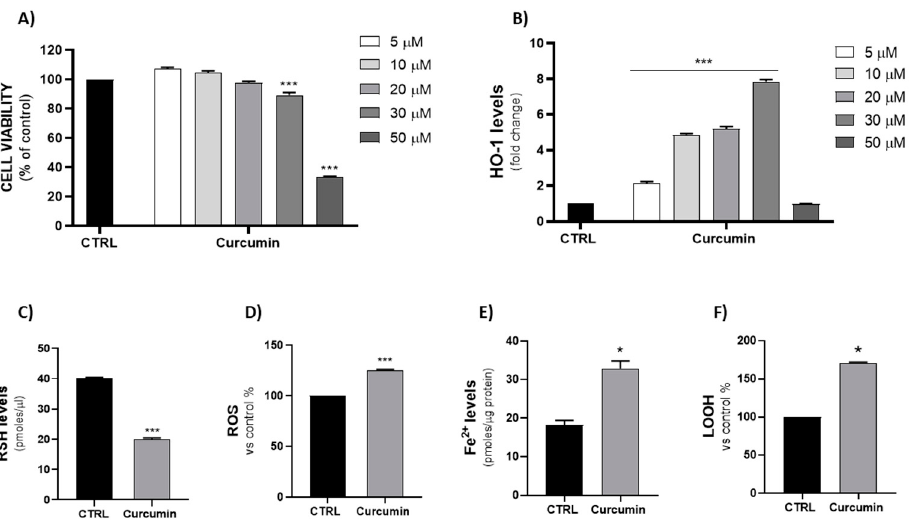
Figure 3. ( A , B ) Evaluation of curcumin (5, 10, 20, 30, 50 µM) treatment on MDA-MB 231 cells’ viability and HO-1 expression levels (*** p < 0.0005 vs. CTRL). ( C – F ) Effect of curcumin (30 µM) on RSH, ROS, Fe 2+ and LOOH levels (* p < 0.05, *** p < 0.0005 vs. CTRL). The results are expressed as means ±